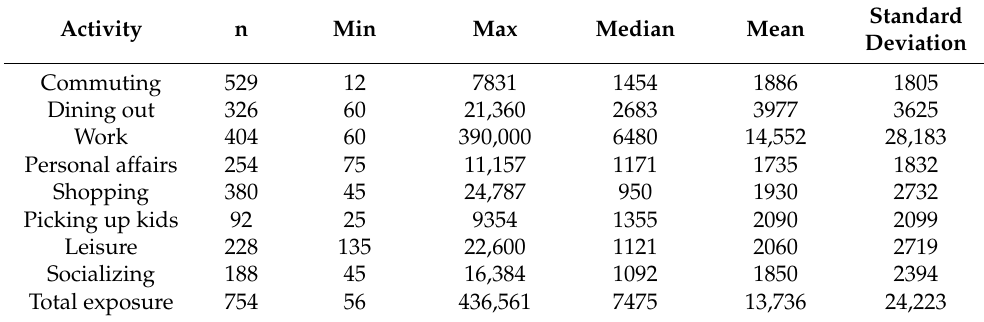
Table A2. Exposure level of all activities within a week.